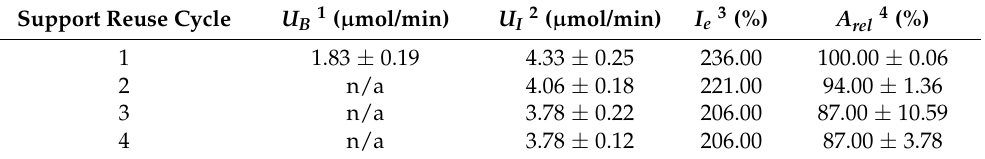
Table 7. Lipolytic activity of immobilized AA-ANL after support reuse (one, two, three, and four cycles). The activity parameter of free AA-ANL is shown as the initial value (one cycle). Support Reuse